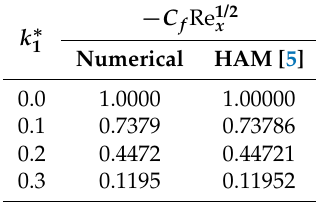
K s  0.7, 0.9, 1.1